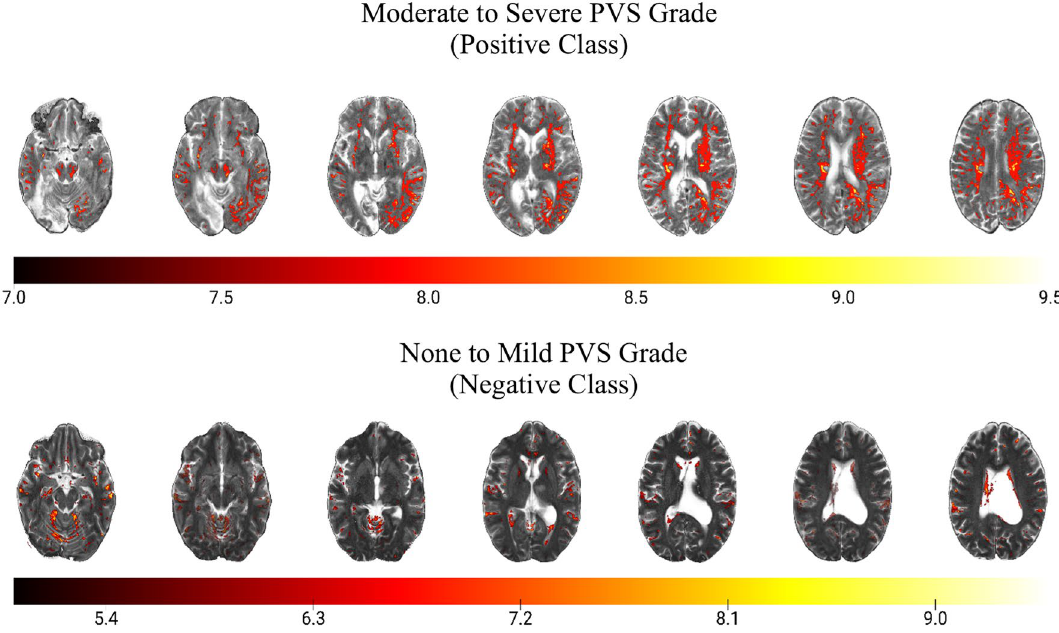
Figure 2. 3D gradient class activation maps (3DGradCAM) showing prototypical activations for examples in each classification (positive versus negative). Positive examples showed high activation in several relevant midline regions, including midbrain, basal ganglia, and centrum semiovale (top panel). Negative examples had fewer activations in the high activation range (> 7) and smaller activations localized in non-relevant (random) areas (bottom